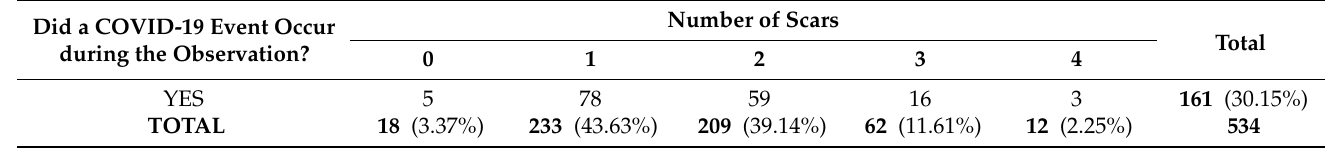
Table 13. The number of COVID-19 incidents depending on the number of scars after BCG vaccination.